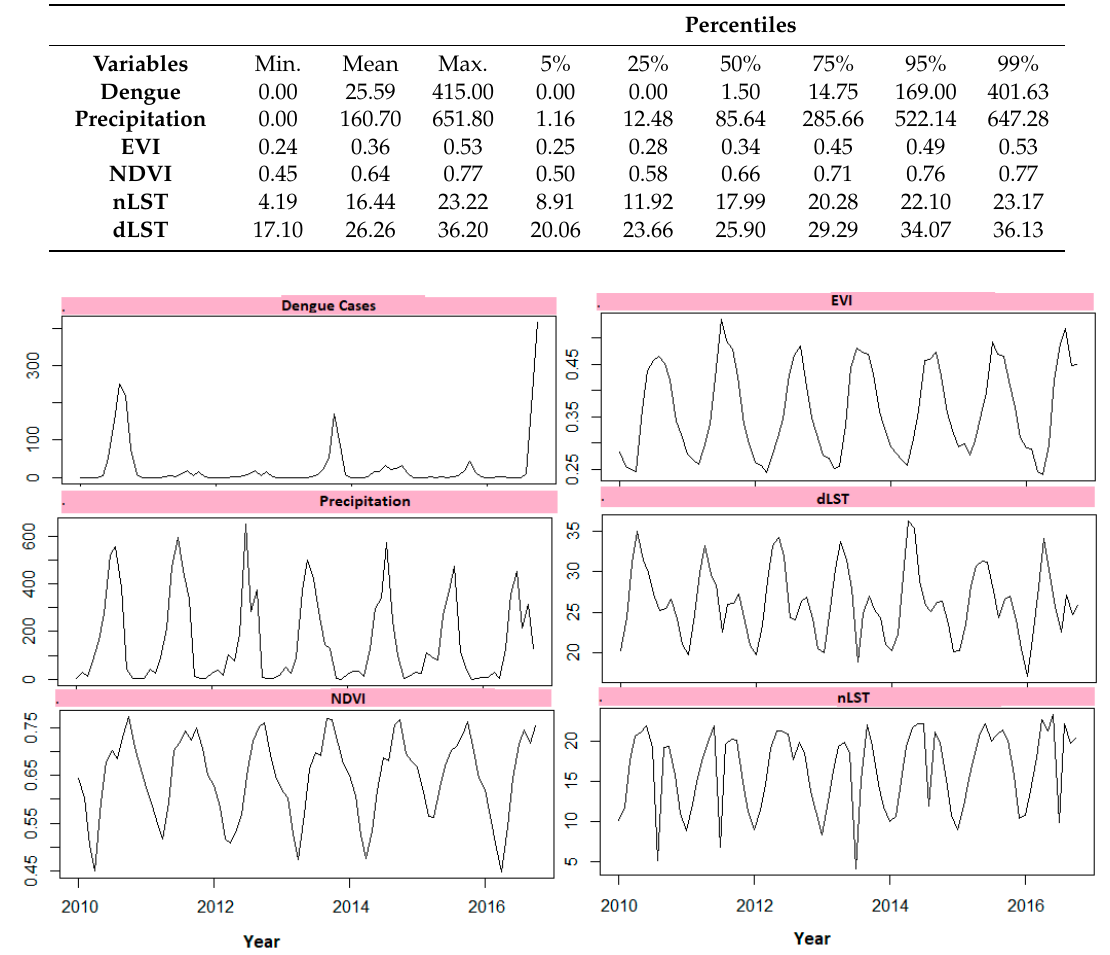
Figure 3. Monthly time series for dengue fever cases, and satellite derived variables:precipitation, normalized difference vegetation index (NDVI), enhanced vegetation index (EVI), daytime land surface temperature (dLST), and nighttime land surface temperature (nLST).